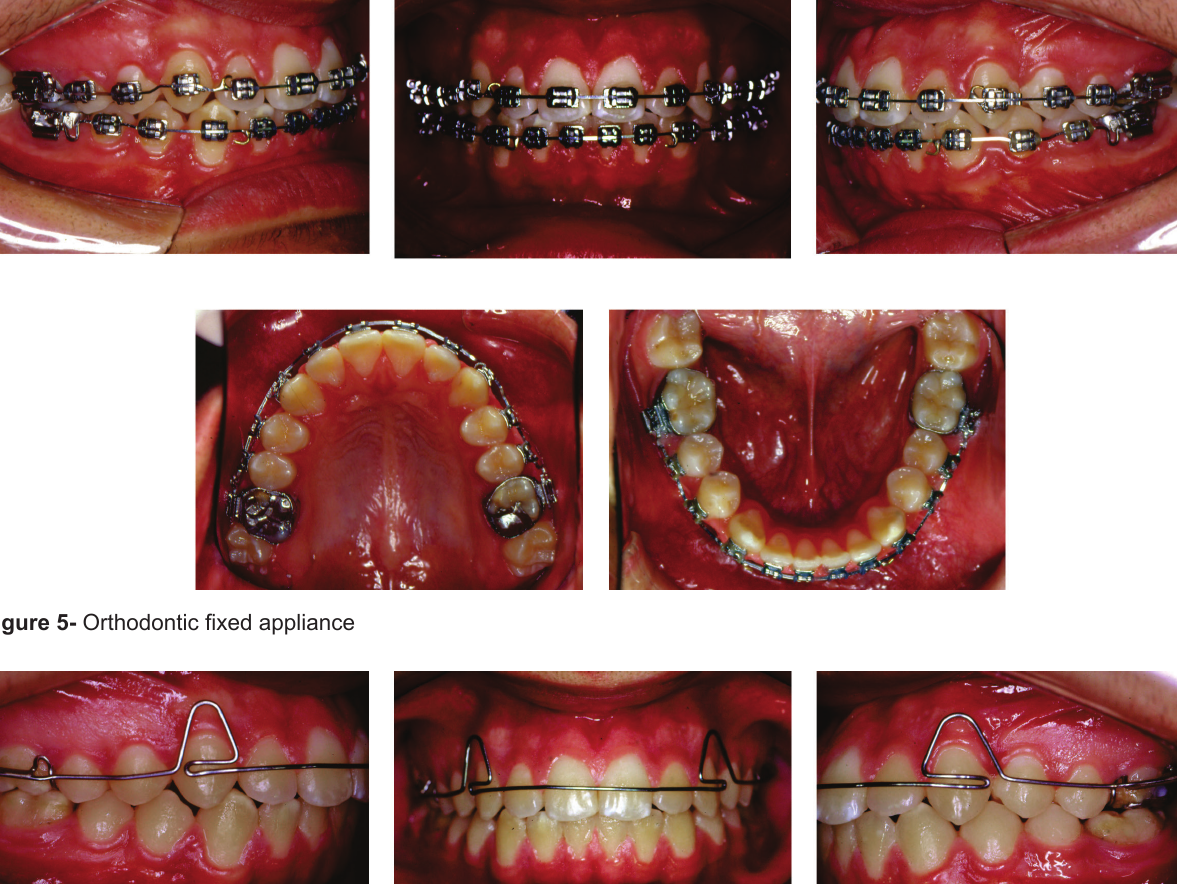
Figure 5- Orthodontic fixed